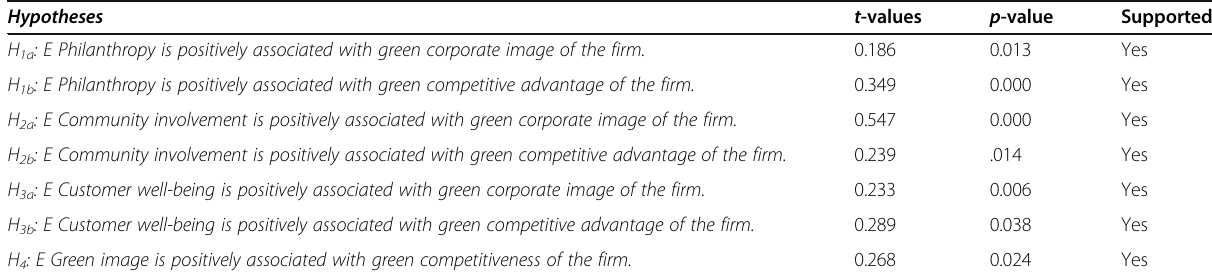
Table 5 Results of the proposed model